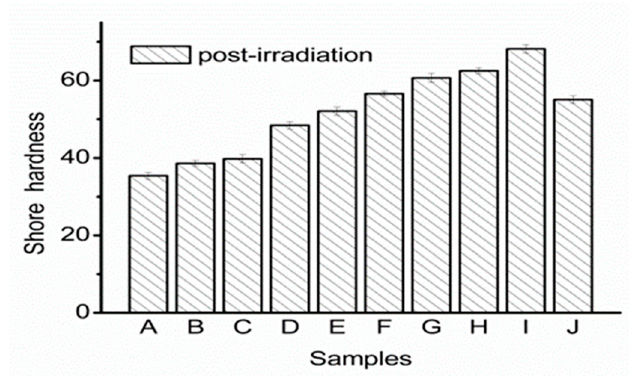
Figure 11. Shore hardness of composite materials.